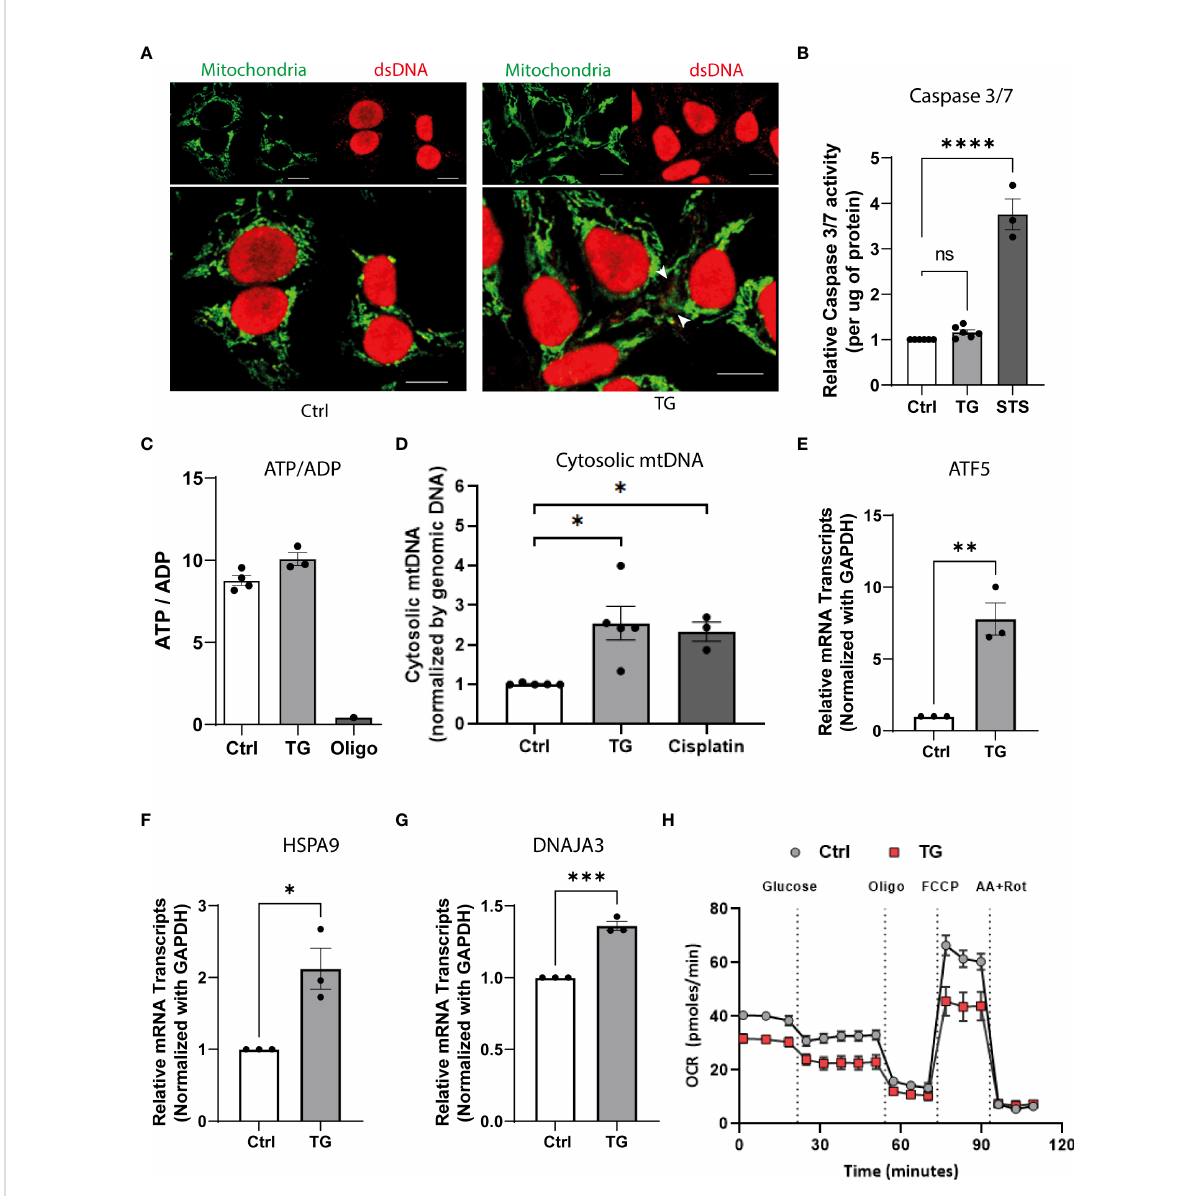
FIGURE 4 ER stress induces mitochondrial damage leading to mtDNA leakage to the cytosol. (A) Confocal imaging of EndoC- b H1 cells exposed to TG (0.1µM; 24h) and stained with anti-dsDNA (red) and anti- mitochondria (green); scale = 10µm. (B) Relative caspase 3/7 activity (expressed per µg of protein) in EndoC- b H1 cells exposed to TG (0.1µM; 24h) or Staurosporine (1µM, 2h). (C) the ATP-on-ADP ratio was calculated after determination of intracellular ATP and ADP levels by HPLC in EndoC- b H1 cell after exposure to TG (0.1 µM, 24h) or oligomycin (1 µM, 24h); ATP/ADP ratios are plotted as a mean ± SEM (n=3). (D) mtDNA cytosolic expression in EndoC- b H1 cell exposed to TG (0.1 µM, 24h) or Cisplatin (1µM, 24h). The results are normalized with nuclear DNA and presented as a mean ± SEM (n=5). (E – G) Relative mRNA expression of mitochondrial stress genes (E) ATF5, (F) HSPA9 and, (G) DNAJA3 in EndoC- b H1 cells exposed to TG. (H) Analysis of metabolic function by measuring oxygen consumption rate (OCR; pmoles/min) in a Seahorse XF analyzer. The graph represents the mean ± SEM (n=5) statistically analyzed by student ’ s t-test. Signi fi cance is indicated by *P < 0.05, **P < 0.01, ***P < 0.001 and ****P <